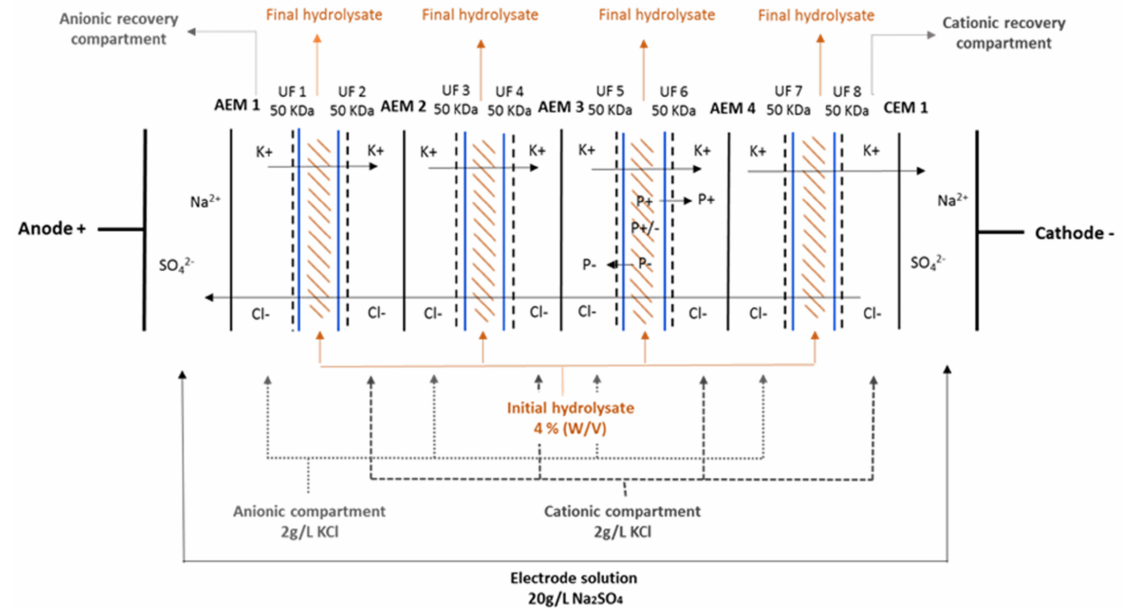
Figure 1. EDUF configuration used for the simultaneous separation of the herring milt hydrolysate: P+/ − neutral peptides, P+ cationic peptides, P − anionic peptides, blue line: filter side of UF membranes, dotted line: other side of the UF